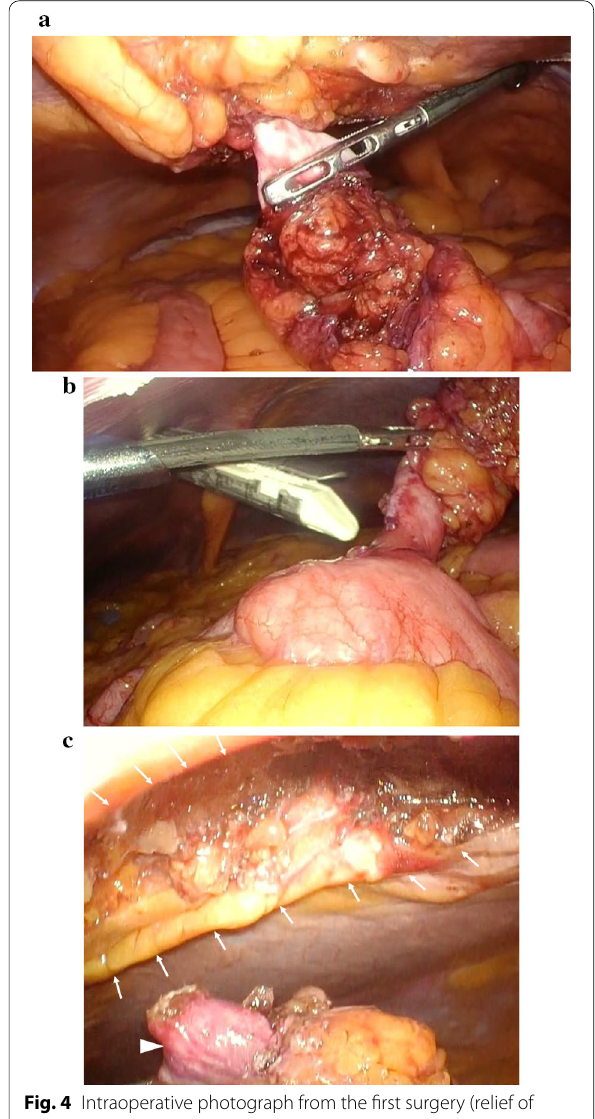
Fig. 4 Intraoperative photograph from the first surgery (relief of incarceration and diverticulectomy). a Meckel’s diverticulum in the umbilical hernia. b Dissection of Meckel’s diverticulum using a linear stapler. c Hernial orifice (arrows) and Meckel’s diverticulum (arrowhead) after relieving